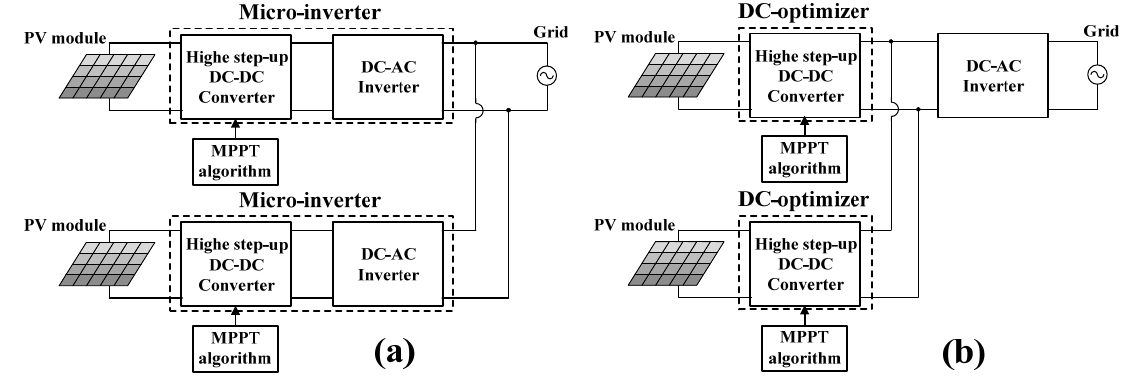
Figure 8. Diagrams of ( a ) the micro-inverter and ( b ) the direct current (DC)-optimizer.